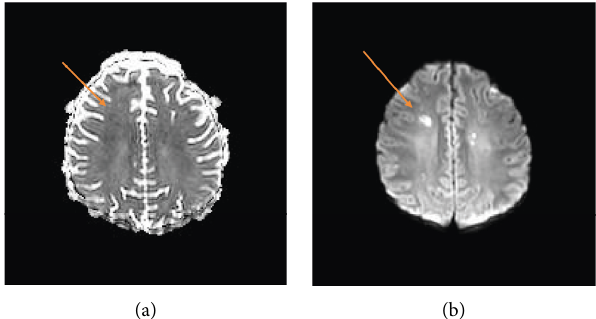
Figure 3: ADC mapping with an area of low signal intensity (left image orange arrow). Diffusion-weighted image showing high signal intensity (right image orange arrow).